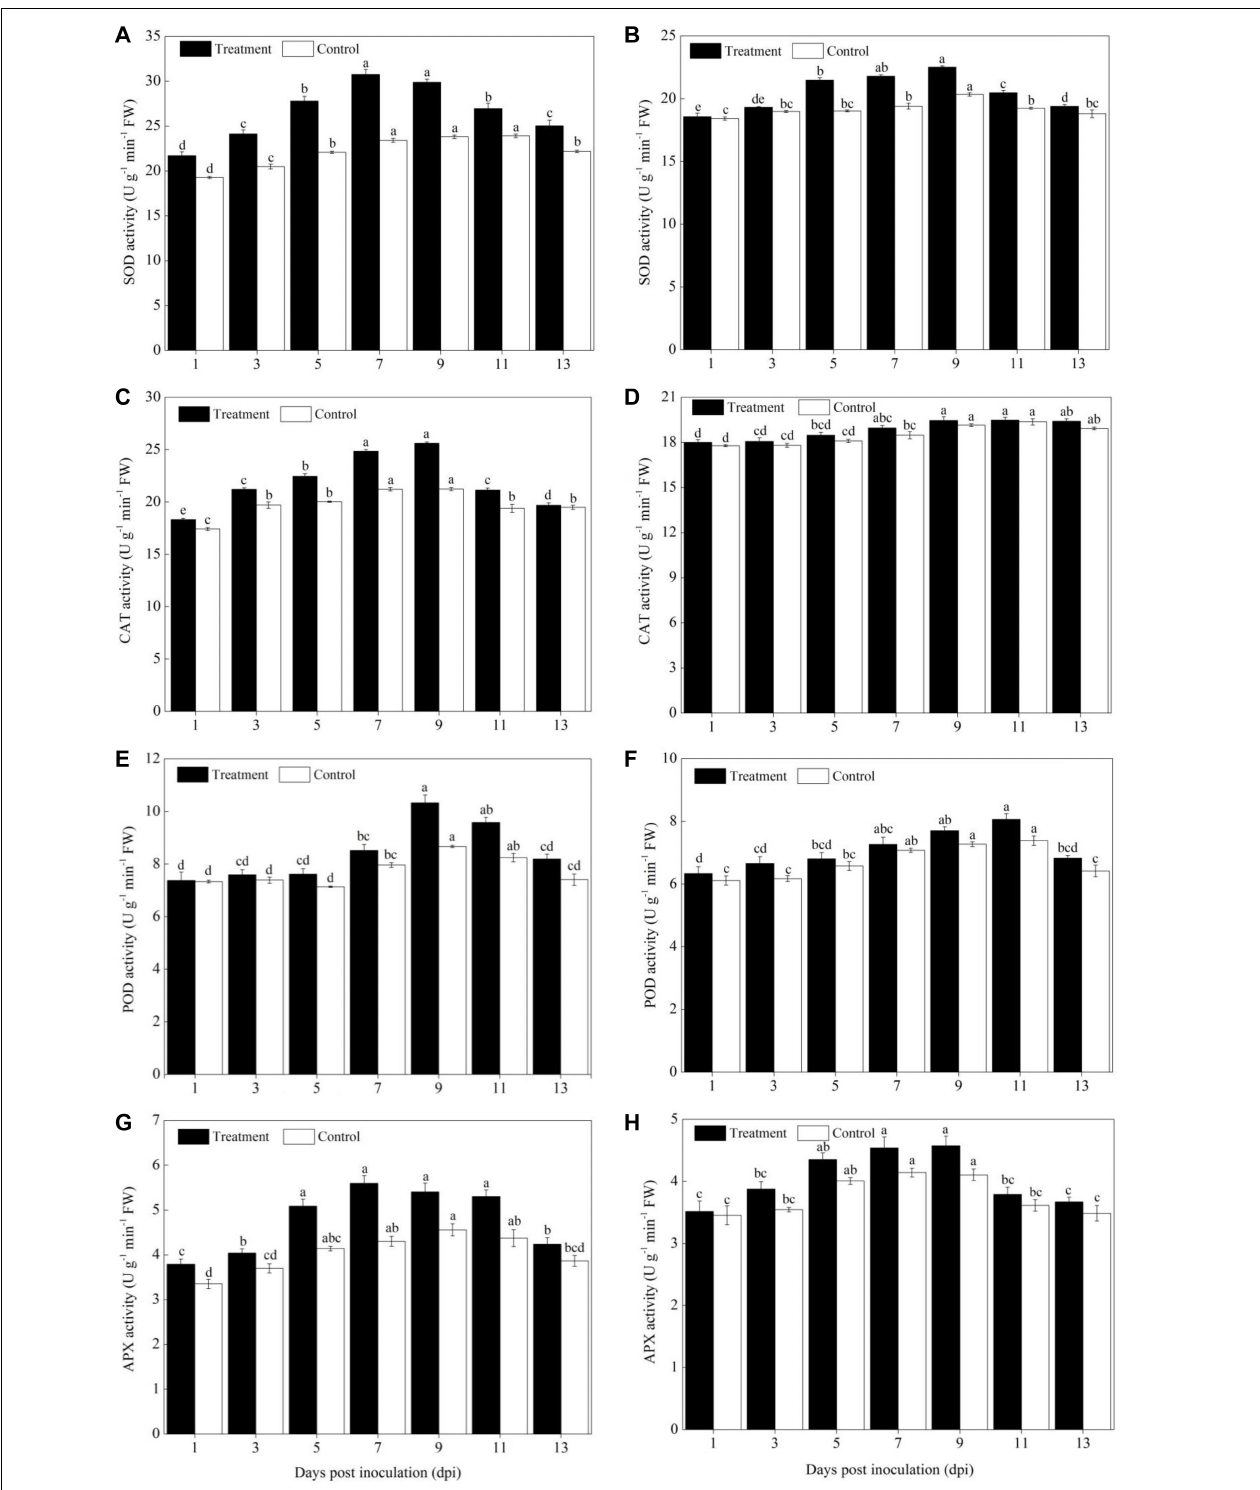
FIGURE 3 | Activities of ROS scavenging enzymes in the leaves of Sixing F 1 and Jin 12 F 1 at different time points after inoculation with Podosphaera xanthii. (A,C,E,G) The activity of SOD, CAT, POD, and APX in Sixing F 1 , respectively; (B,D,F,H) the activity of SOD, CAT, POD, and APX in Jin 12 F 1 , respectively. The line bars, different letters, and the treatments are detailed in the footnote of Figure 2 and Table 2